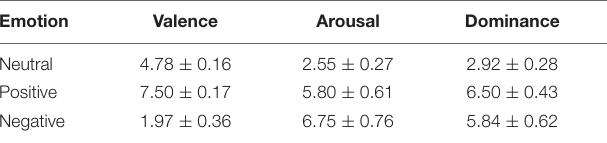
TABLE 1 | Descriptive statistics of valence, arousal and dominance of material ( M ±